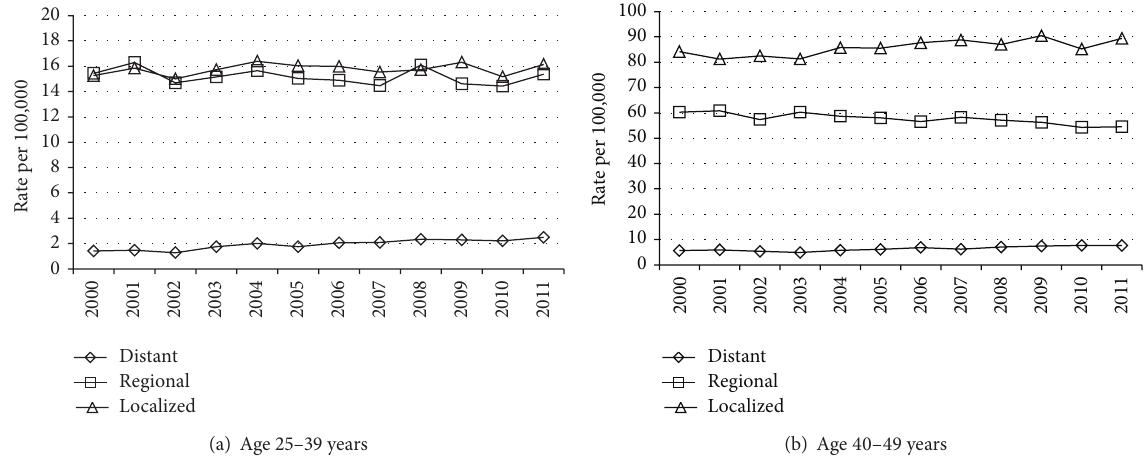
Figure 1: Age-standardized incidence rate for invasive breast cancer diagnosed at ages 25–39 years and 40–49 years in 2000–2011, SEER registries, by summary